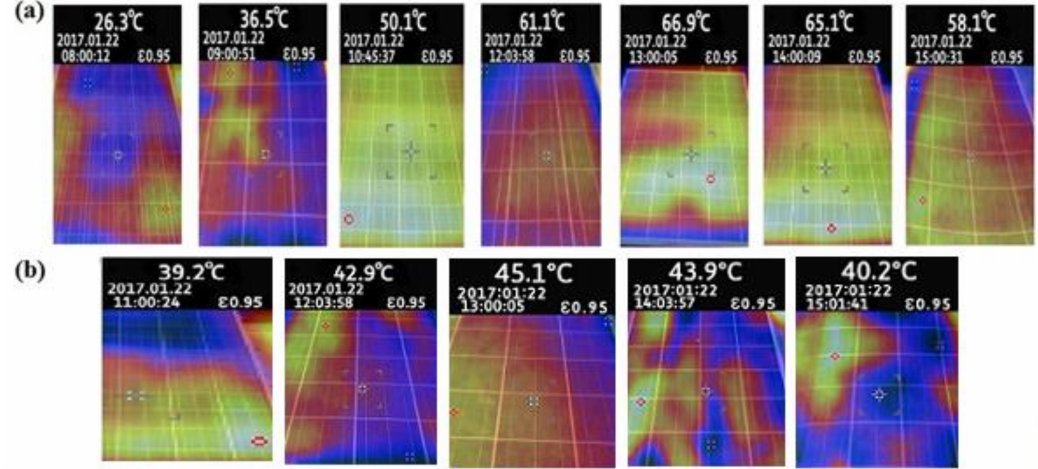
Figure 13. Comparative assessment of temperature ( a ) No cooling system; ( b ) CLC-SS. Table 6. Temperature of solar Panel without cooling system and